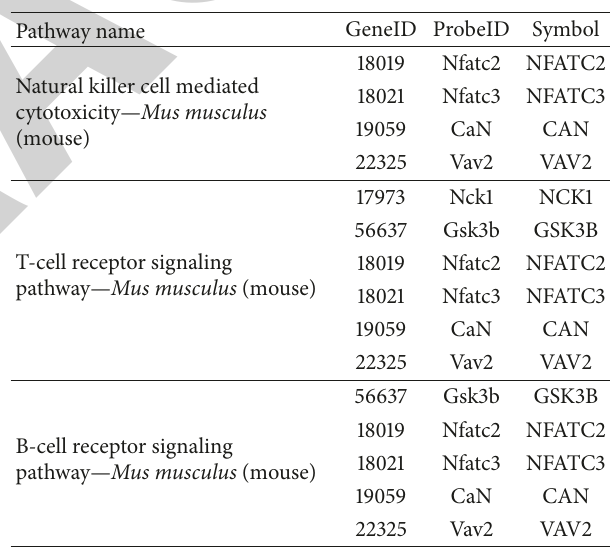
Table 3: Upregulated genes in T-cell receptor signaling pathway, B-cell receptor signaling pathway, and natural killer cell